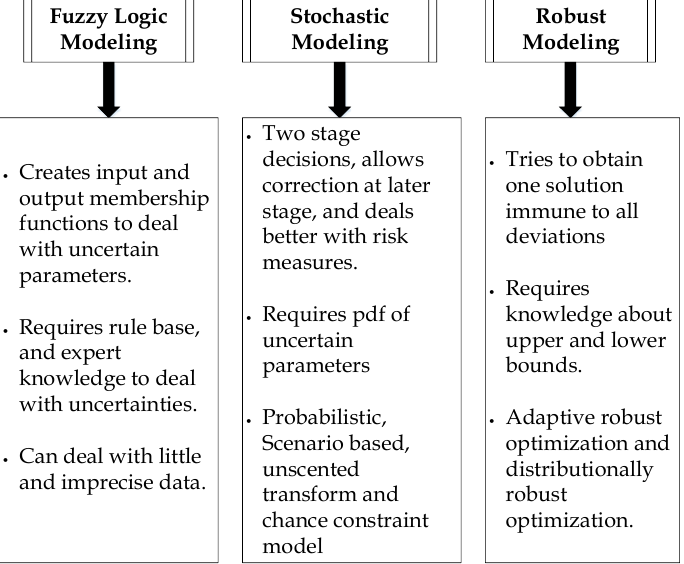
Figure 5. Classification of uncertainty modeling.